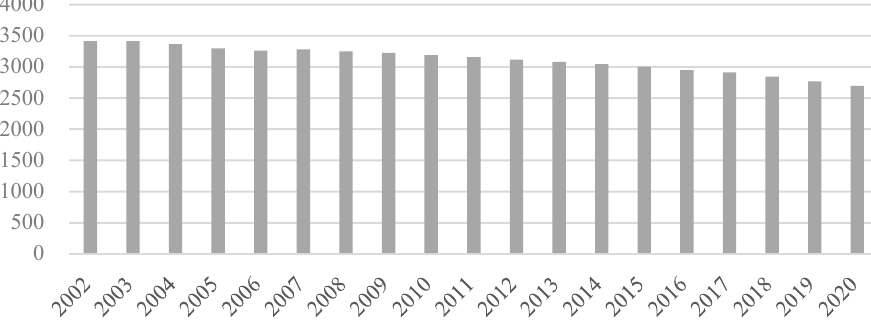
Figure 1. Recent changes in the number of FPCs (created from [29]).